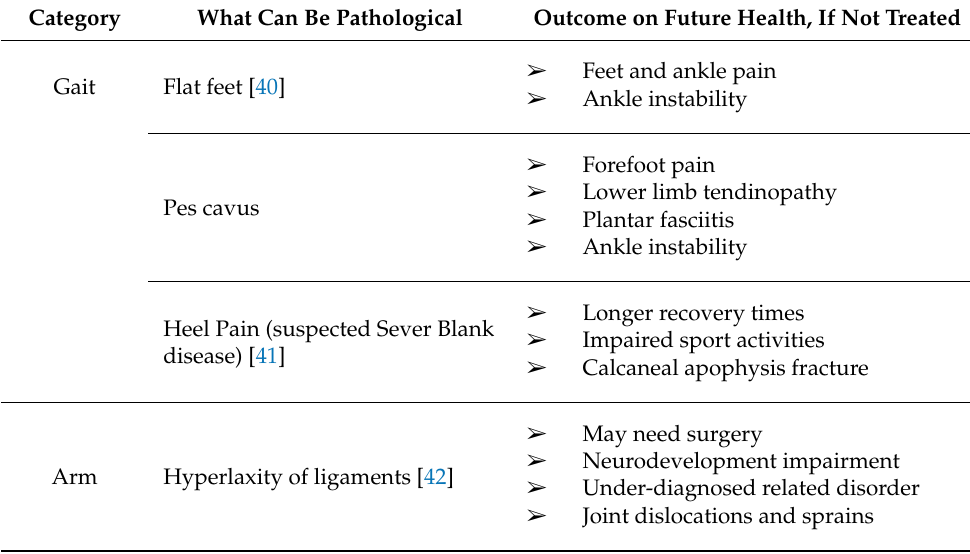
Table 3. Important musculoskeletal (MSK) conditions to search in the sports medicine pre- participation evaluation